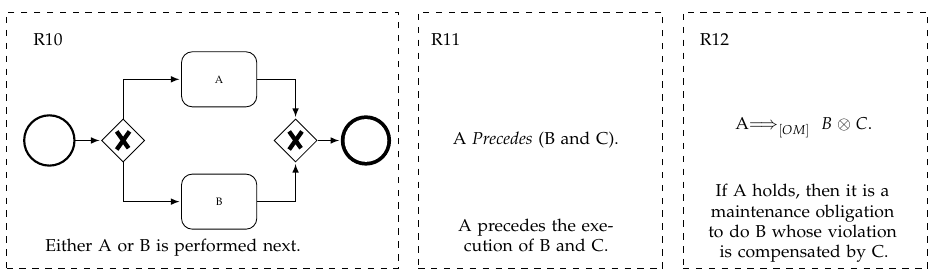
Figure 10. Example of the operator and operand